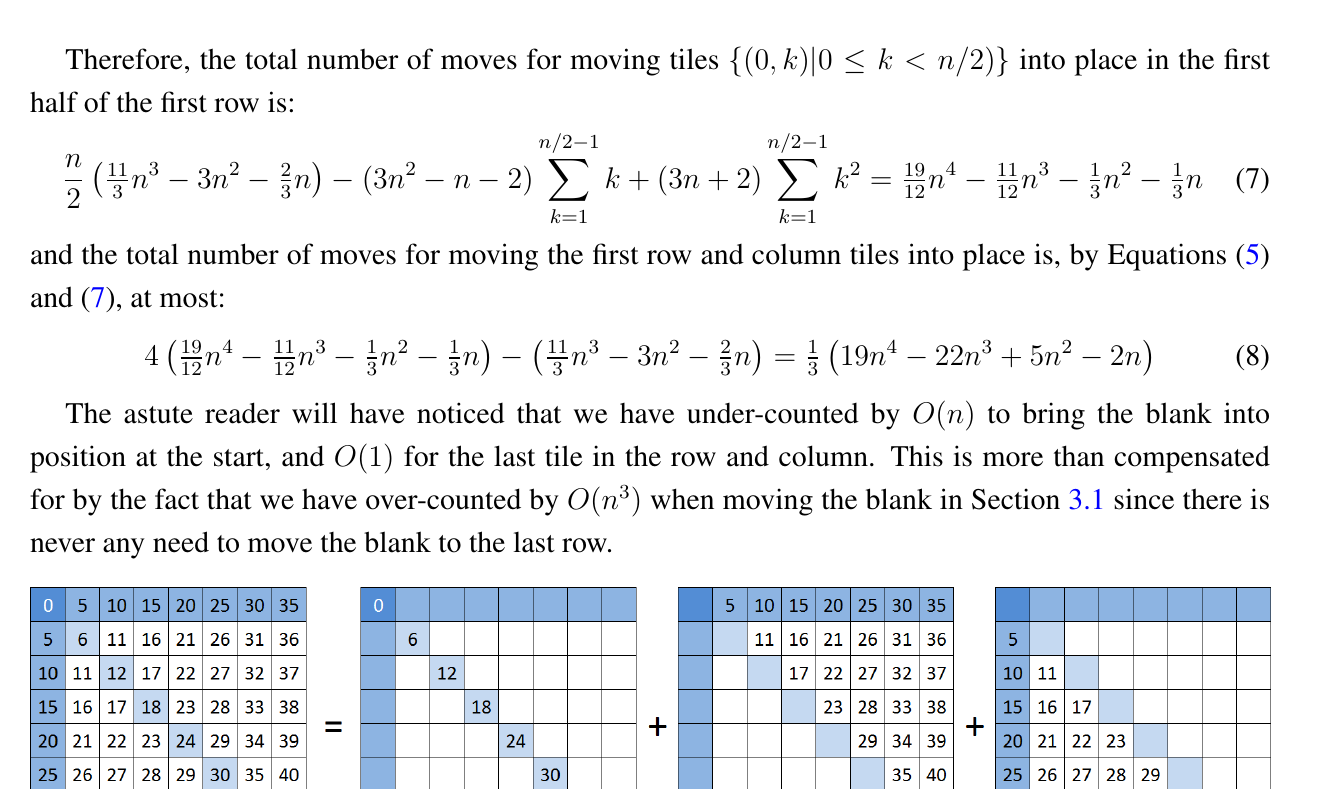
Figure 3. Number of moves required to move a tile from each position to the first half of the first row of the